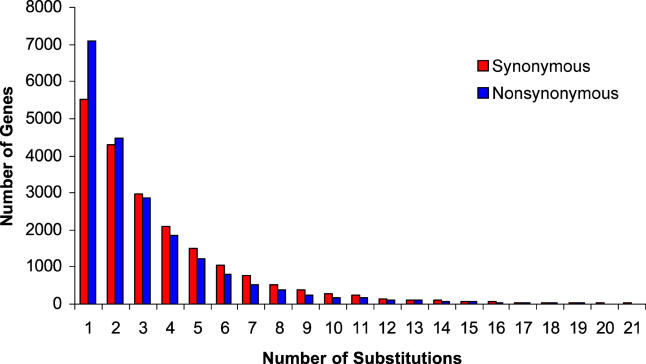
Distribution of MutationsThe figure shows the number of synonymous and nonsynonymous nucleotide differences in 13,731 human–chimpanzee orthologous gene pairs.